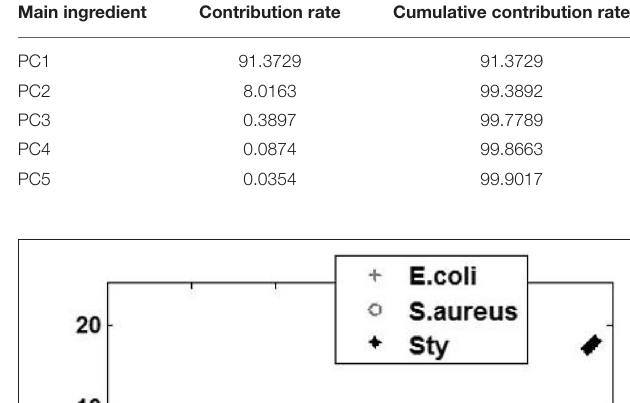
TABLE 1 | Contribution rate and cumulative contribution rate of the first five principal components. Main ingredient